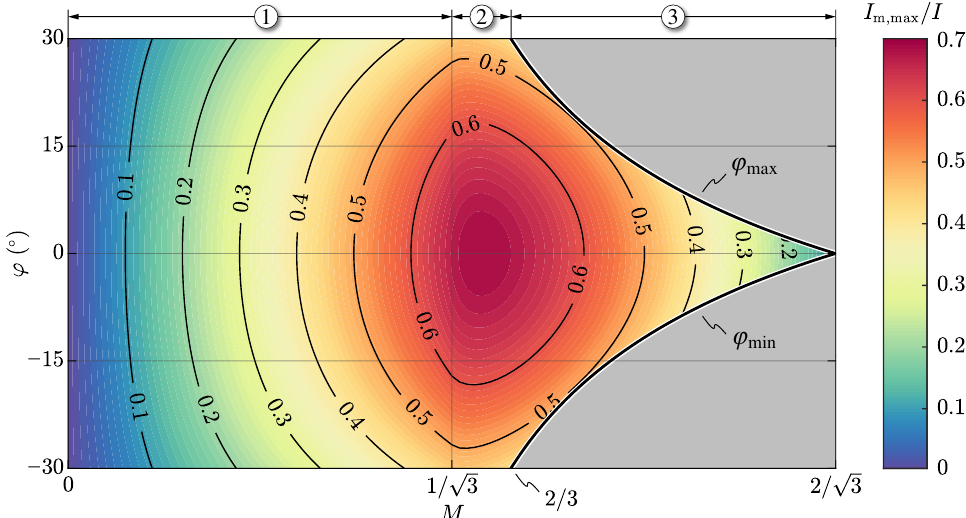
Figure A3. Maximum mid-point current periodical average I m,max (i.e., normalized with respect to the peak phase current I ) as a function of the modulation index M and the converter-side power factor angle ϕ . The three modulation index regions 1 , 2 and 3 are